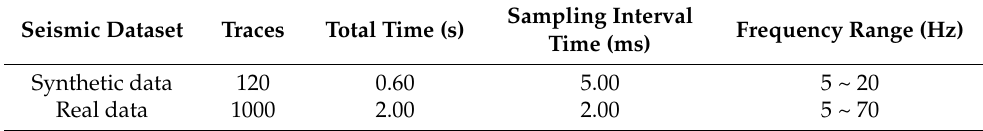
Table 6. Quantitative comparison of the real and synthetic datasets in our experiments. Seismic